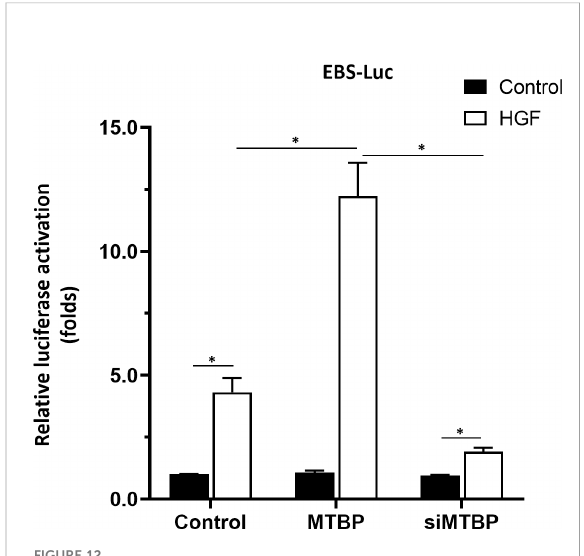
FIGURE 12 MTBP enhances the activation of EBS-Luc in Huh-7 cells. Huh-7 cells were transfected with control, MTBP or siMTBP and co- transfected with EBS-Luc. Then, cell were analyzed by luciferase. *P <